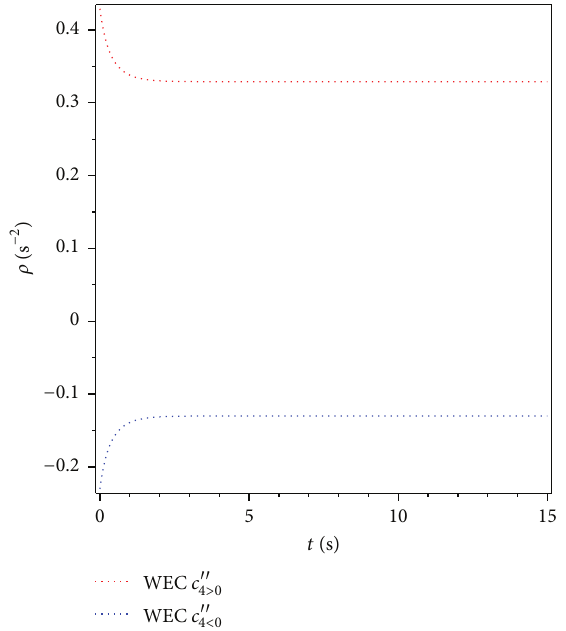
Figure 8: The evolution of DEC for open model. Here the sign of the three constants 𝑐 󸀠 1 , 𝑐 󸀠 2 , and 𝑐 󸀠 3 has no effect on the evolution of DEC; however, 𝑐 󸀠 4 must have positive value to satisfy the